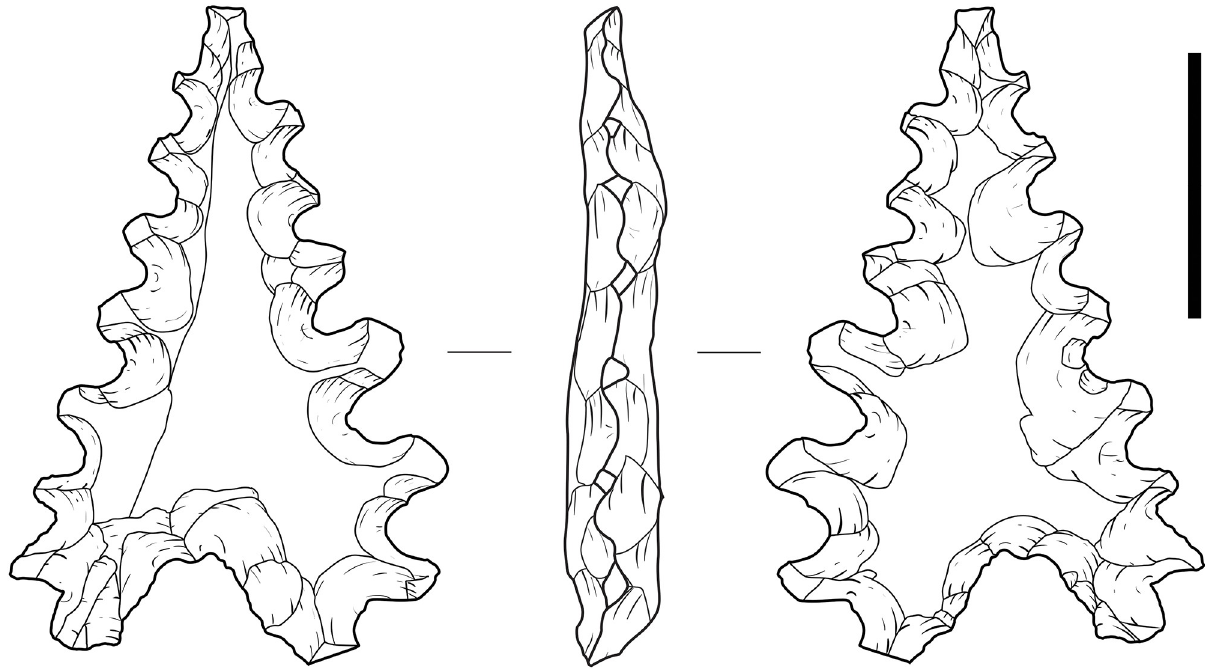
Fig 11. A classic Maros point. Point recovered from Leang Pajae, Test Pit 1, 20–30 cm below the surface. Scale bar = 1 cm.